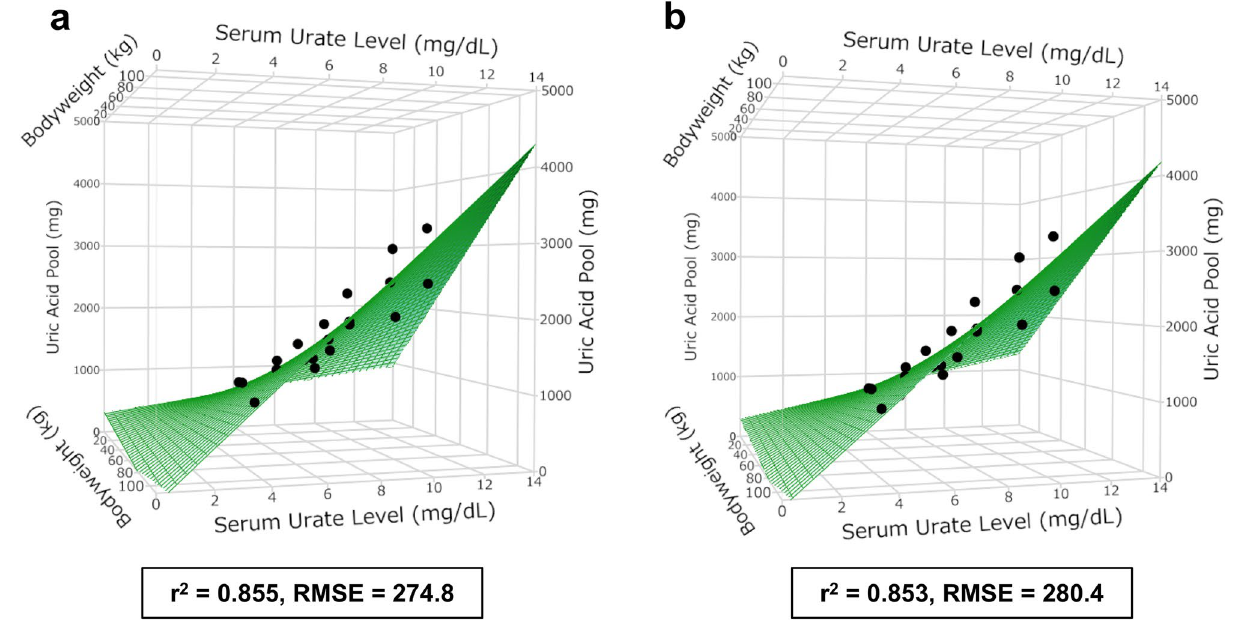
Figure 2. Conversion model of serum urate level adjusted by hematocrit (SUA Ht ) and bodyweight to uric acid pool size derived from data for ( a ) adults and ( b ) adult males only in previous radio-isotopic studies. ( a ) Uric acid pool (mg) = 231.3 × SUA Ht (mg∕dL) + 15.1 × bodyweight (kg) + [(SUA Ht −7.763) × (Bodyweight−75.55)] × 2.476−1131, r 2 = 0.855, RMSE = 274.8. (b) Uric acid pool (mg) = 235.9 × SUA Ht (mg∕dL) + 12.72 × bodyweight (kg) + [(SUA Ht −7.652) × (bodyweight−77.55)] × 2.116−961.8, r 2 = 0.853, RMSE =